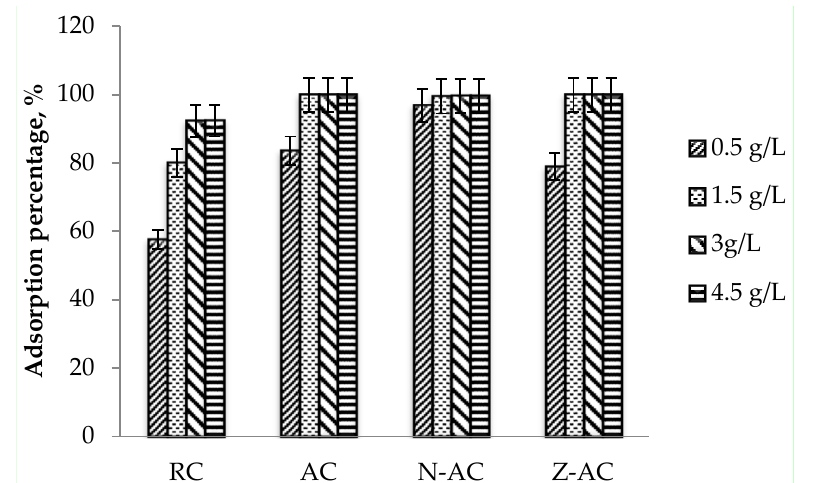
Figure 9. Plot of the adsorption percentage of ofloxacin onto all types of cassava stem adsorbents against different adsorbent dosages (condition: pH 5; contact time = 180 min; initial ofloxacin concentration = 100 ppm; temperature = 55 °C).